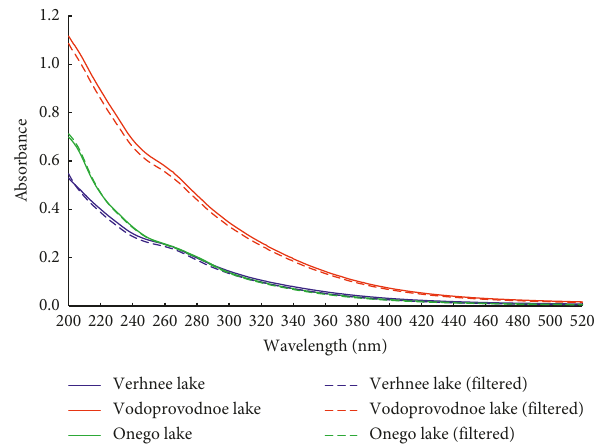
Figure 1: Absorption spectra of surface freshwater from three Karelian lakes, unfiltered (solid lines) and filtered (dashed lines).